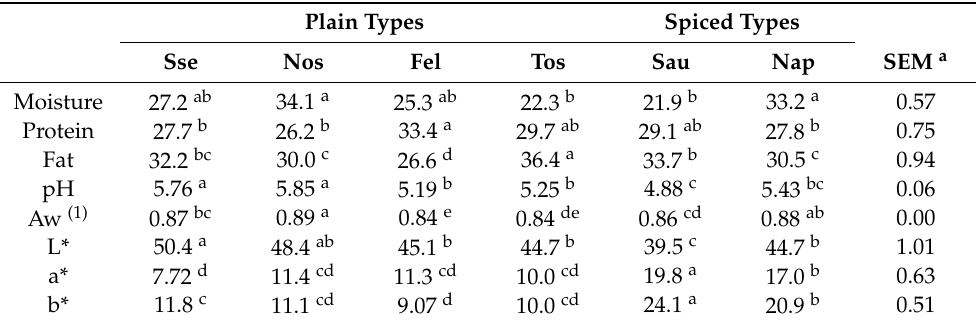
Table 3. Product quality attributes including proximate composition, pH, water activity and instru- mental colour (lightness L*, redness a*, yellowness b*) of six commercial fermented meat products ( n =